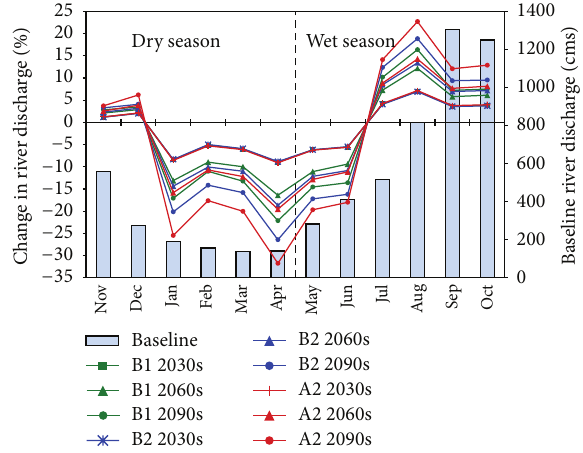
Figure 9: Monthly change in river discharge at Yen Thuong Station (line chart) relative to the average data of the baseline period (column